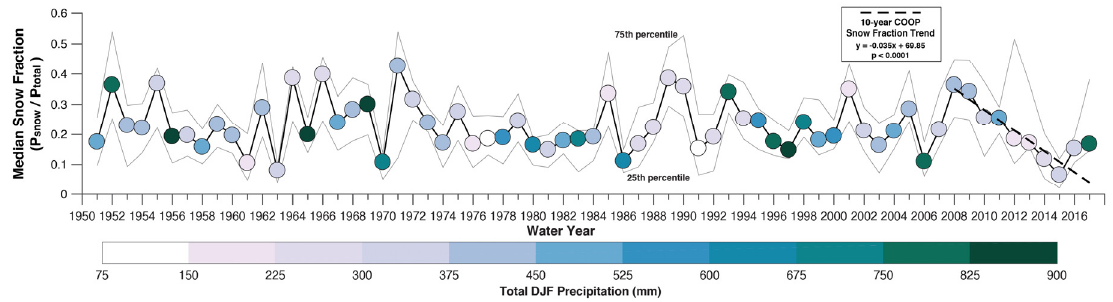
Figure 5. Median winter snow fraction for nine COOP stations between WY1951 and 2017. Dots are colored by total winter precipitation. The grey lines indicate the upper and lower quartile values.